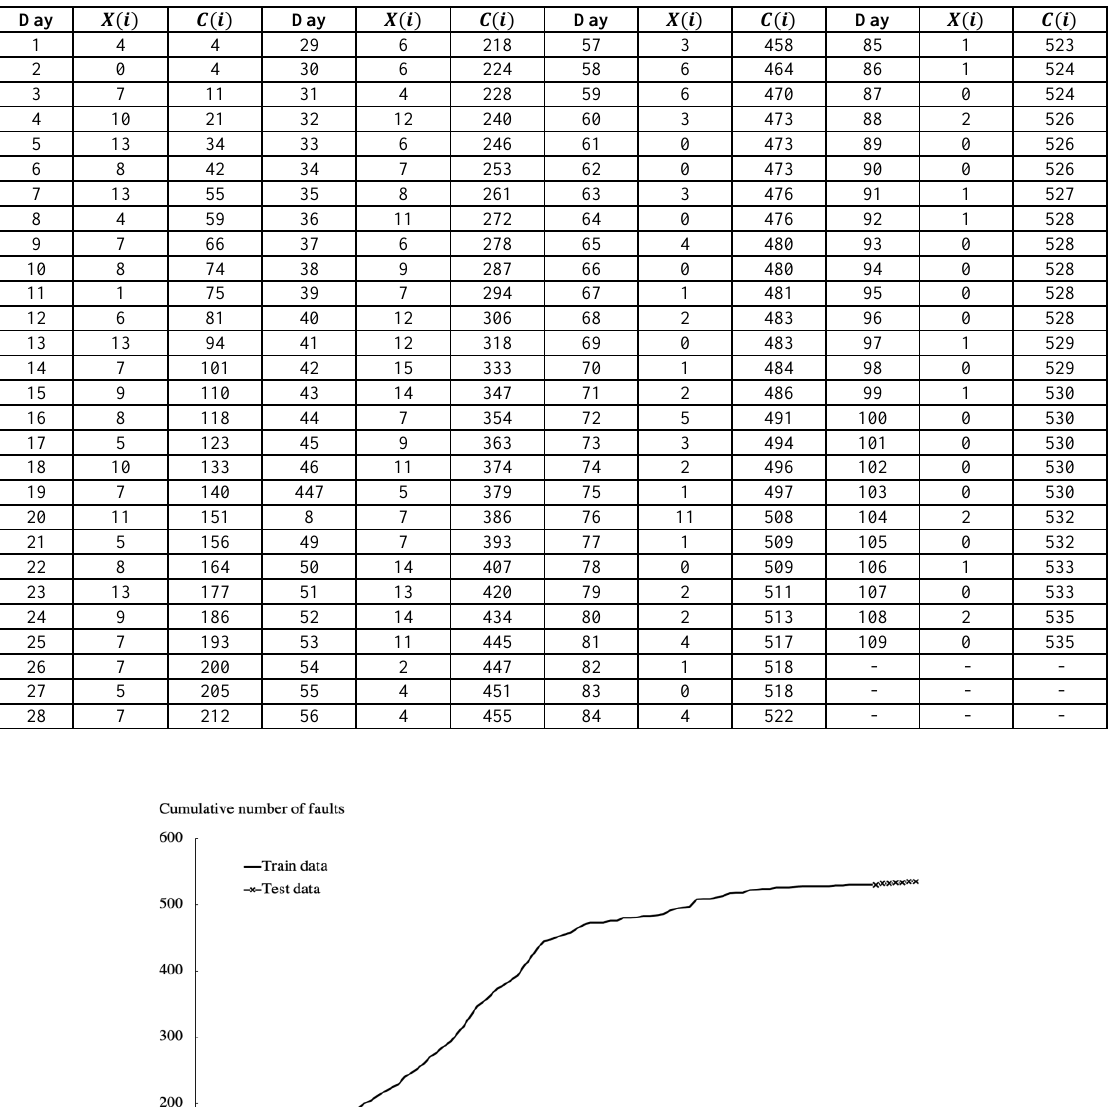
Table 2. The benchmark fault dataset.